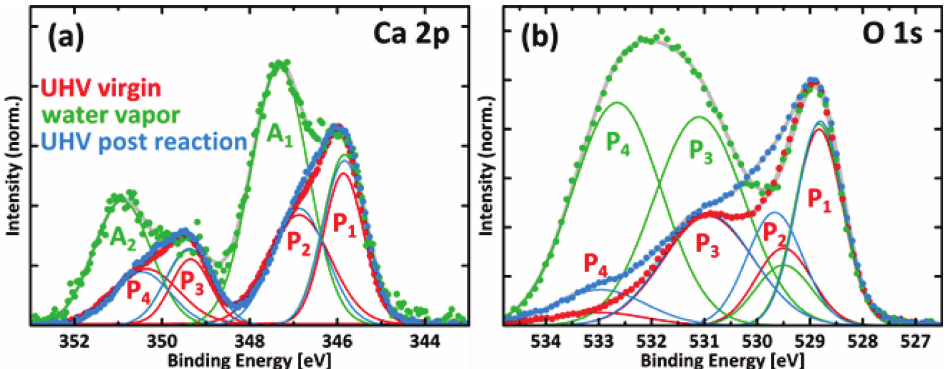
Figure A3. Peak analysis of XPS data before (red) and during insertion of 0.1 mbar H with sample bias of +2.5 V against grounded chamber (green), as well as in UHV after reoxidation in 0.1 mbar O2 (blue). ( a ) Ca 2p states; ( b ) O 1s